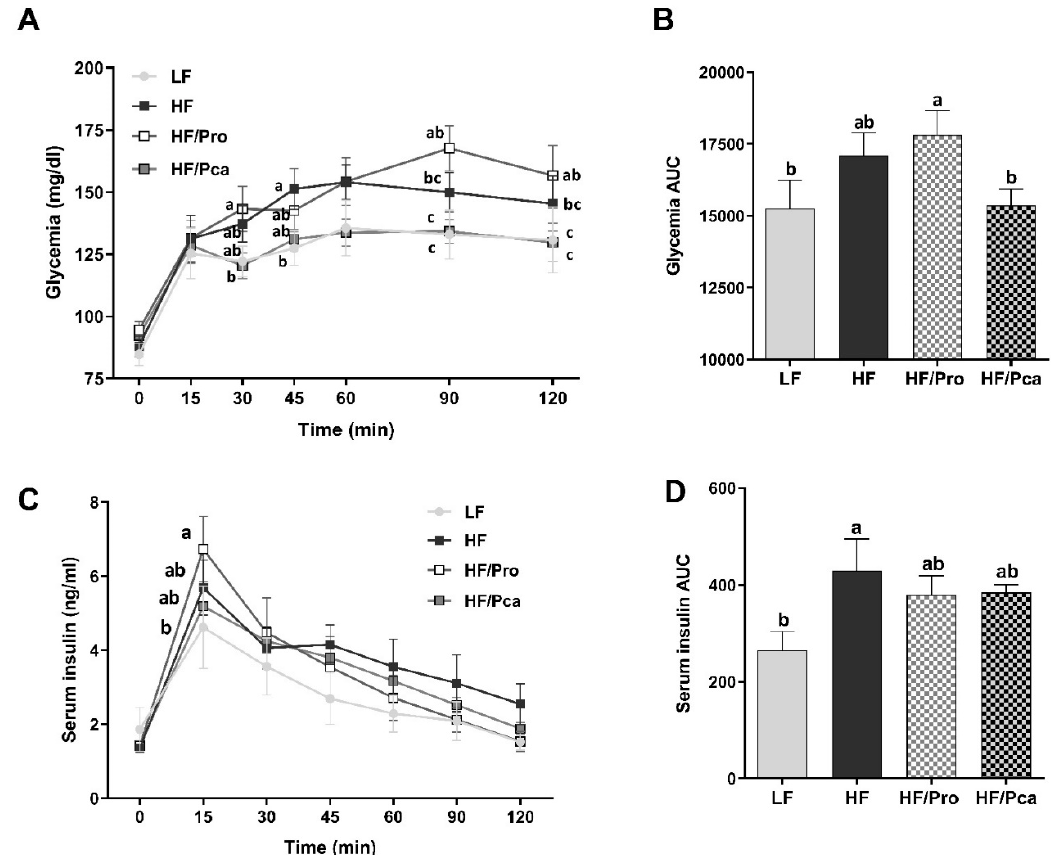
Figure 2. Encapsulation of probiotic bacteria improved glucose intolerance. Glycemia ( A , B ) and insulinemia ( C , D ) were measured during an OGTT (2 mg/kg) in rats fed an LF, HF, HF/Pro, or HF/Pca diet for seven weeks. Values are means ± SEMs; n = 8/group. a,b,c means with different letters are statistically significant, p < 0.05. HF, high fat; HF/Pca, HF with supplemented with encapsulated L. casei W8 (4 × 10 7 cfu/g diet); HF/Pro, HF supplemented with non-encapsulated L. casei W8 (4 × 10 7 cfu/g diet); LF, low fat.